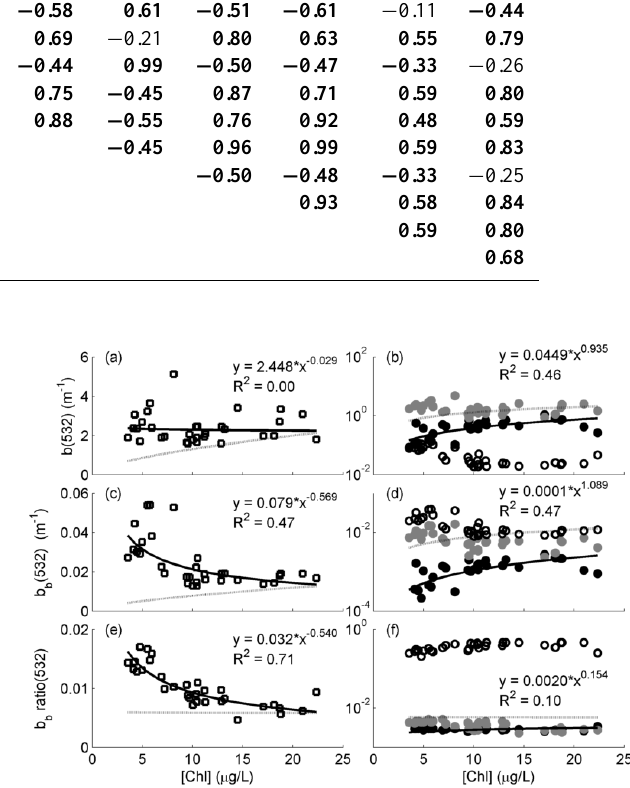
Fig. 6. Relationships of [Chl] HPLC with the scattering coefficient ( a and b ), the backscattering coefficient ( c and d ), and the backscat- tering ratio ( e and f ). Open squares (left column) are the bulk pa- rameters estimated directly from the measured VSFs. Open circles, grey circles and black circles (right column) are the variables for the particle groups of VSP, NAP and PHY, derived from the VSF- inversion. The dotted gray line in each panel represents the cor- responding open ocean water model from Huot et al. (2008). The solid line in each panel represents a power-law regression against [Chl] HPLC of b nw (532), b bnw (532) or ˜ b bnw (532) in (a) , (c) and (e) respectively or of b PHY (532), b bPHY (532) or ˜ b bPHY (532) in (b) , (d) and (f) respectively. The equation of this power-law regression and the corresponding coefficient of determination ( R 2 ) are also shown in each